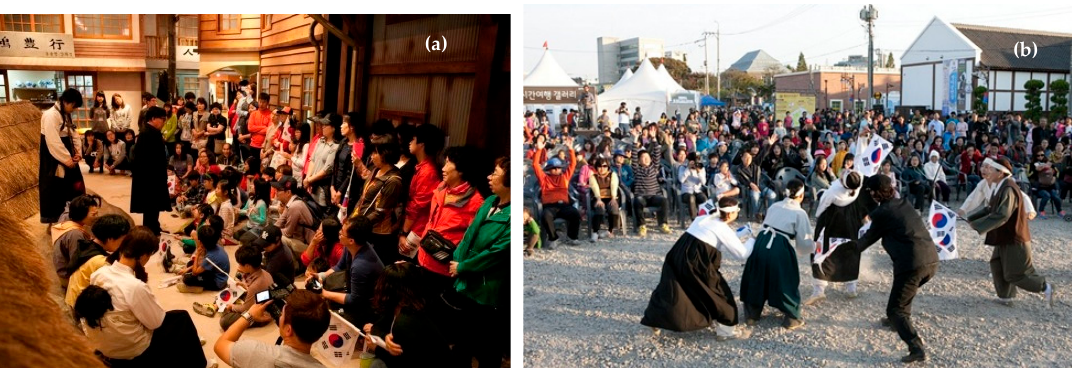
Figure 7. ( a ) Visitors Participation Program at Gunsan Modern History Museum. ( b ) Citizen participation even, “Gunsan Modernity as You Say” (©Festival